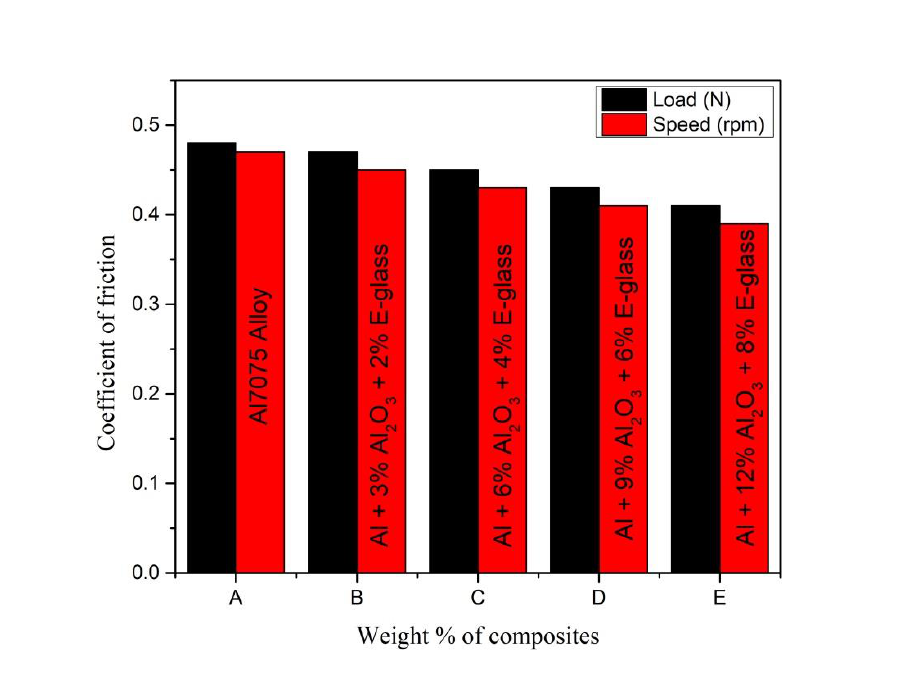
Fig.10. Friction coefficient of hybrid